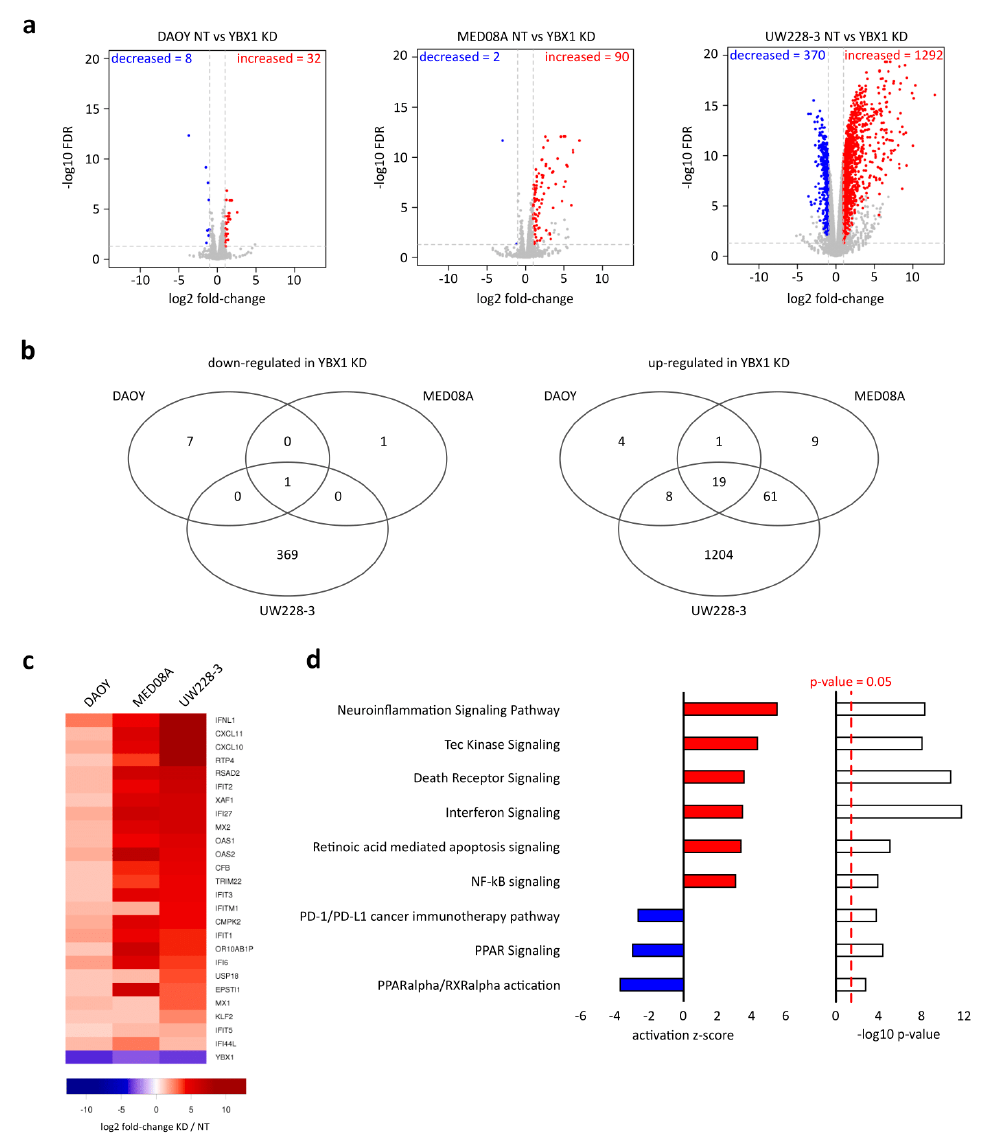
Figure 2. YBX1 knockdown globally induces inflammatory signaling cascades leading to apoptosis. ( a ) Volcano plot representations of differentially expressed genes in three medulloblastoma cell lines upon YBX1 KD. Differentially expressed genes are highlighted (FDR < 0.05; log2FC > 1 or log2FC < - 1). ( b ) Venn diagrams for the overlap of differentially expressed genes across the three cell lines as highlighted in a). ( c ) Differential expression of commonly deregulated genes across all three cell lines as depicted in b). Heatmap shows the log2 fold-change in each cell line between YBX1 KD and NT control. ( d ) Ingenuity Pathway Analysis (IPA) was performed on all differentially expressed genes in UW228-3 as highlighted in a). Bar plots represent activation z-score and –log10 p -value upon YBX1 KD of the canonical pathway analysis of IPA.